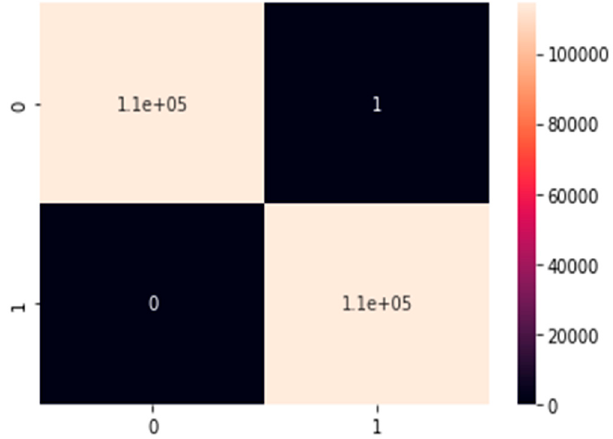
Figure 4. Binary-class confusion matrix.